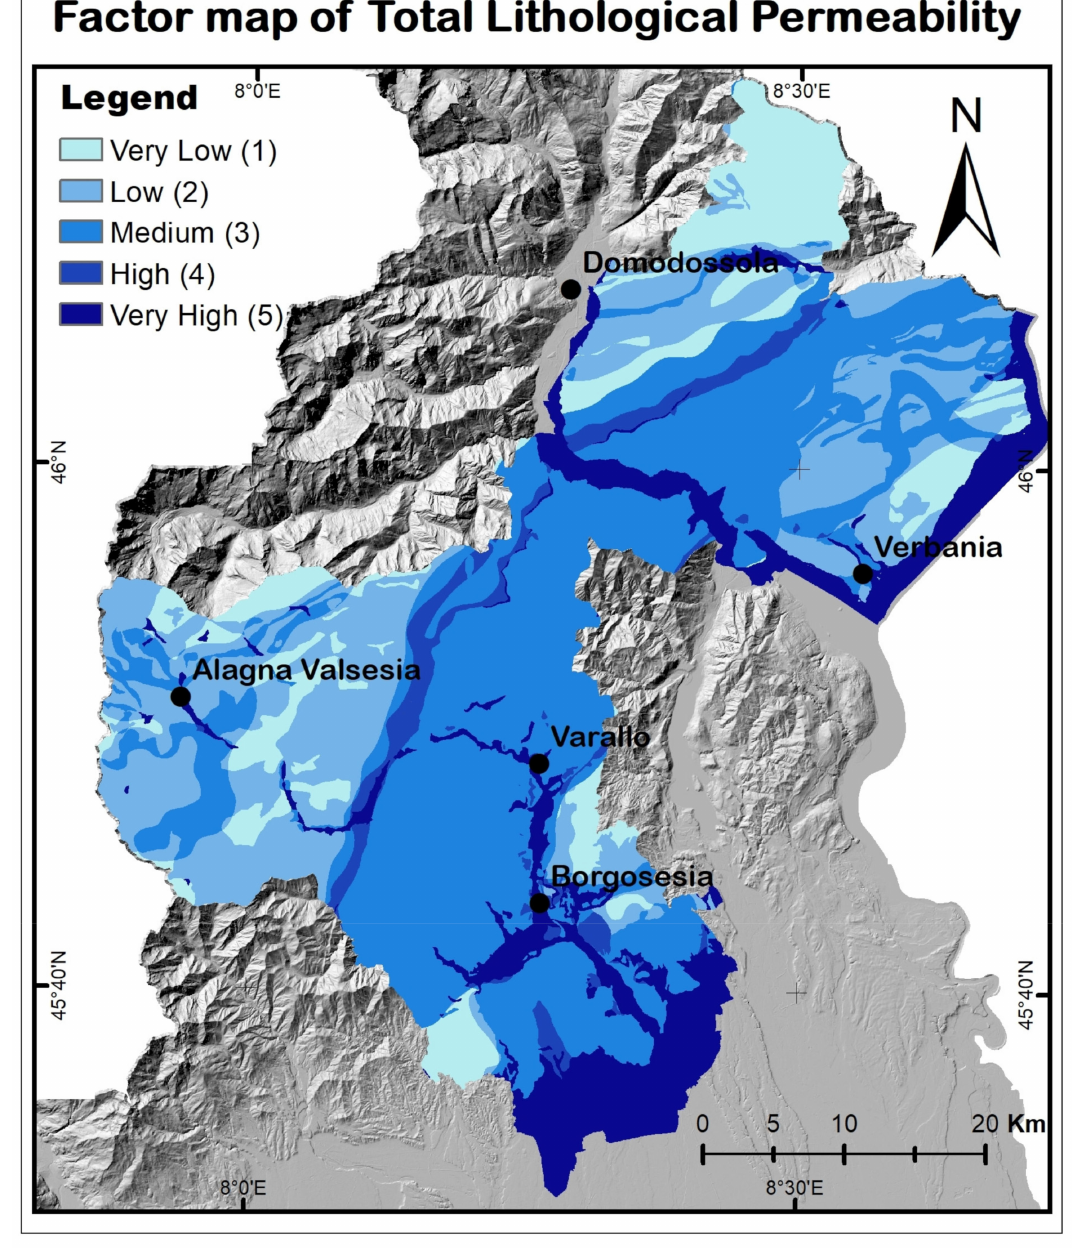
Figure 6. Factor map of lithological permeability integrated with fracturing index. (Esri ArcGis 10.5,